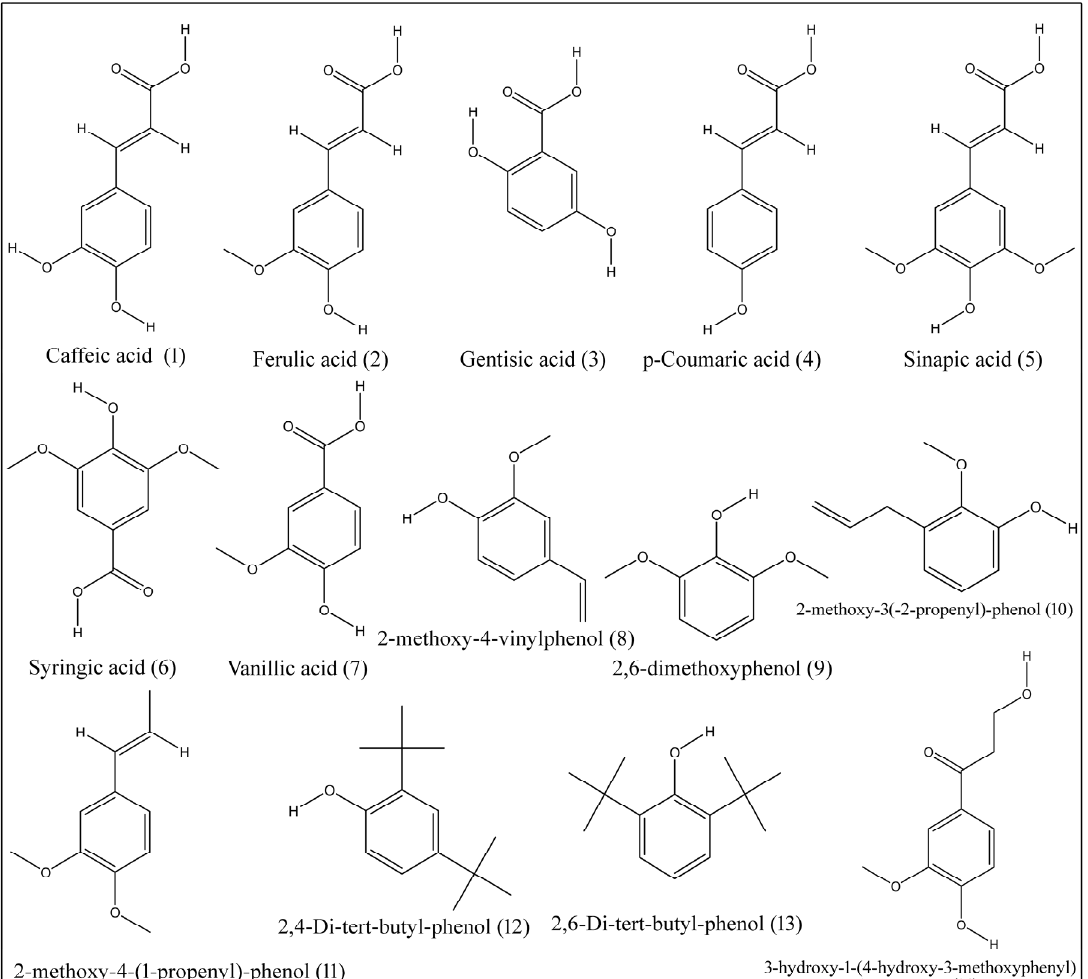
Figure 2. Structures of phenolic compounds isolated from desert